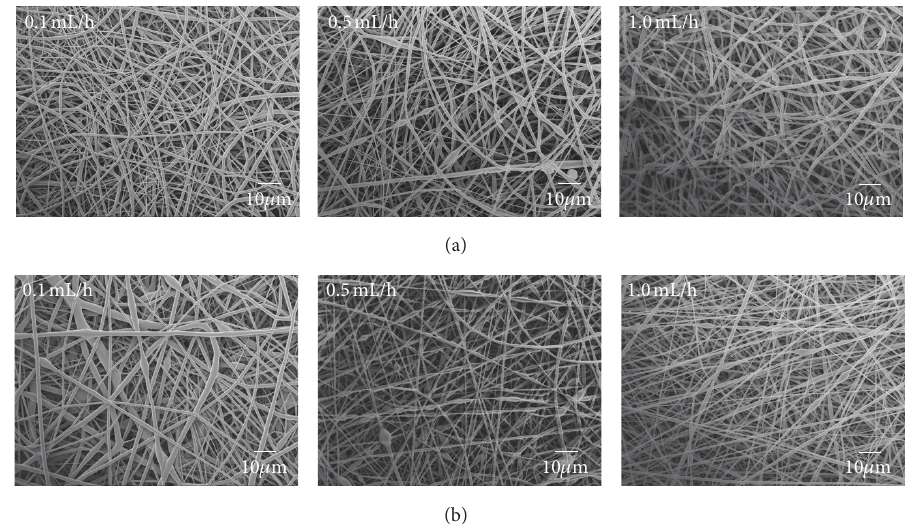
Figure 3: FE-SEM images showing the morphology of fibrous PDLLA prepared with varying flow rates. (a) PDLLA-R; (b) PDLLA-COOH.